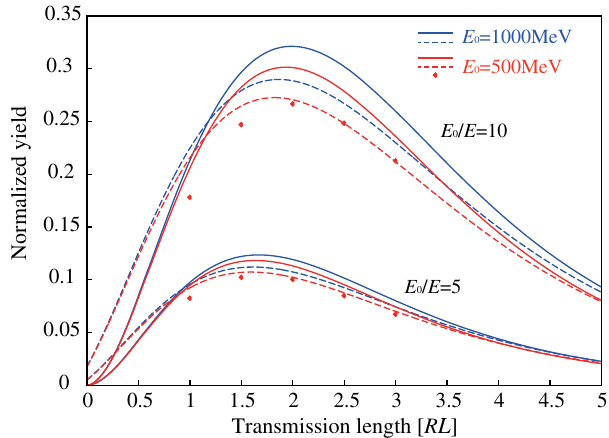
FIG. 2. Comparison of positron yields obtained by different methods with incident energies of 500 MeV and 1000 MeV. The dash lines were calculated by approximate solution of Eq. (9), the continuous curves were obtained by a numerical method, and the dots were simulated by Geant4.